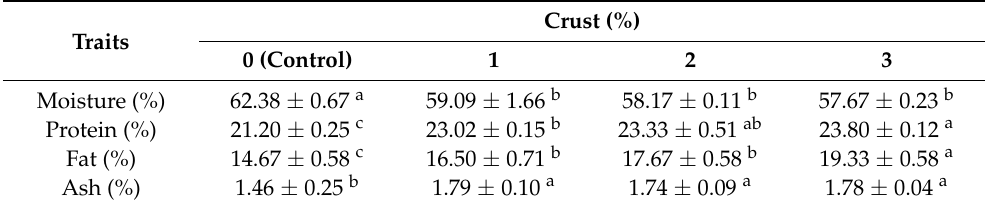
Table 2. Proximate composition of the pork patties formulated with various levels of crust derived from dry-aged beef (Hanwoo).